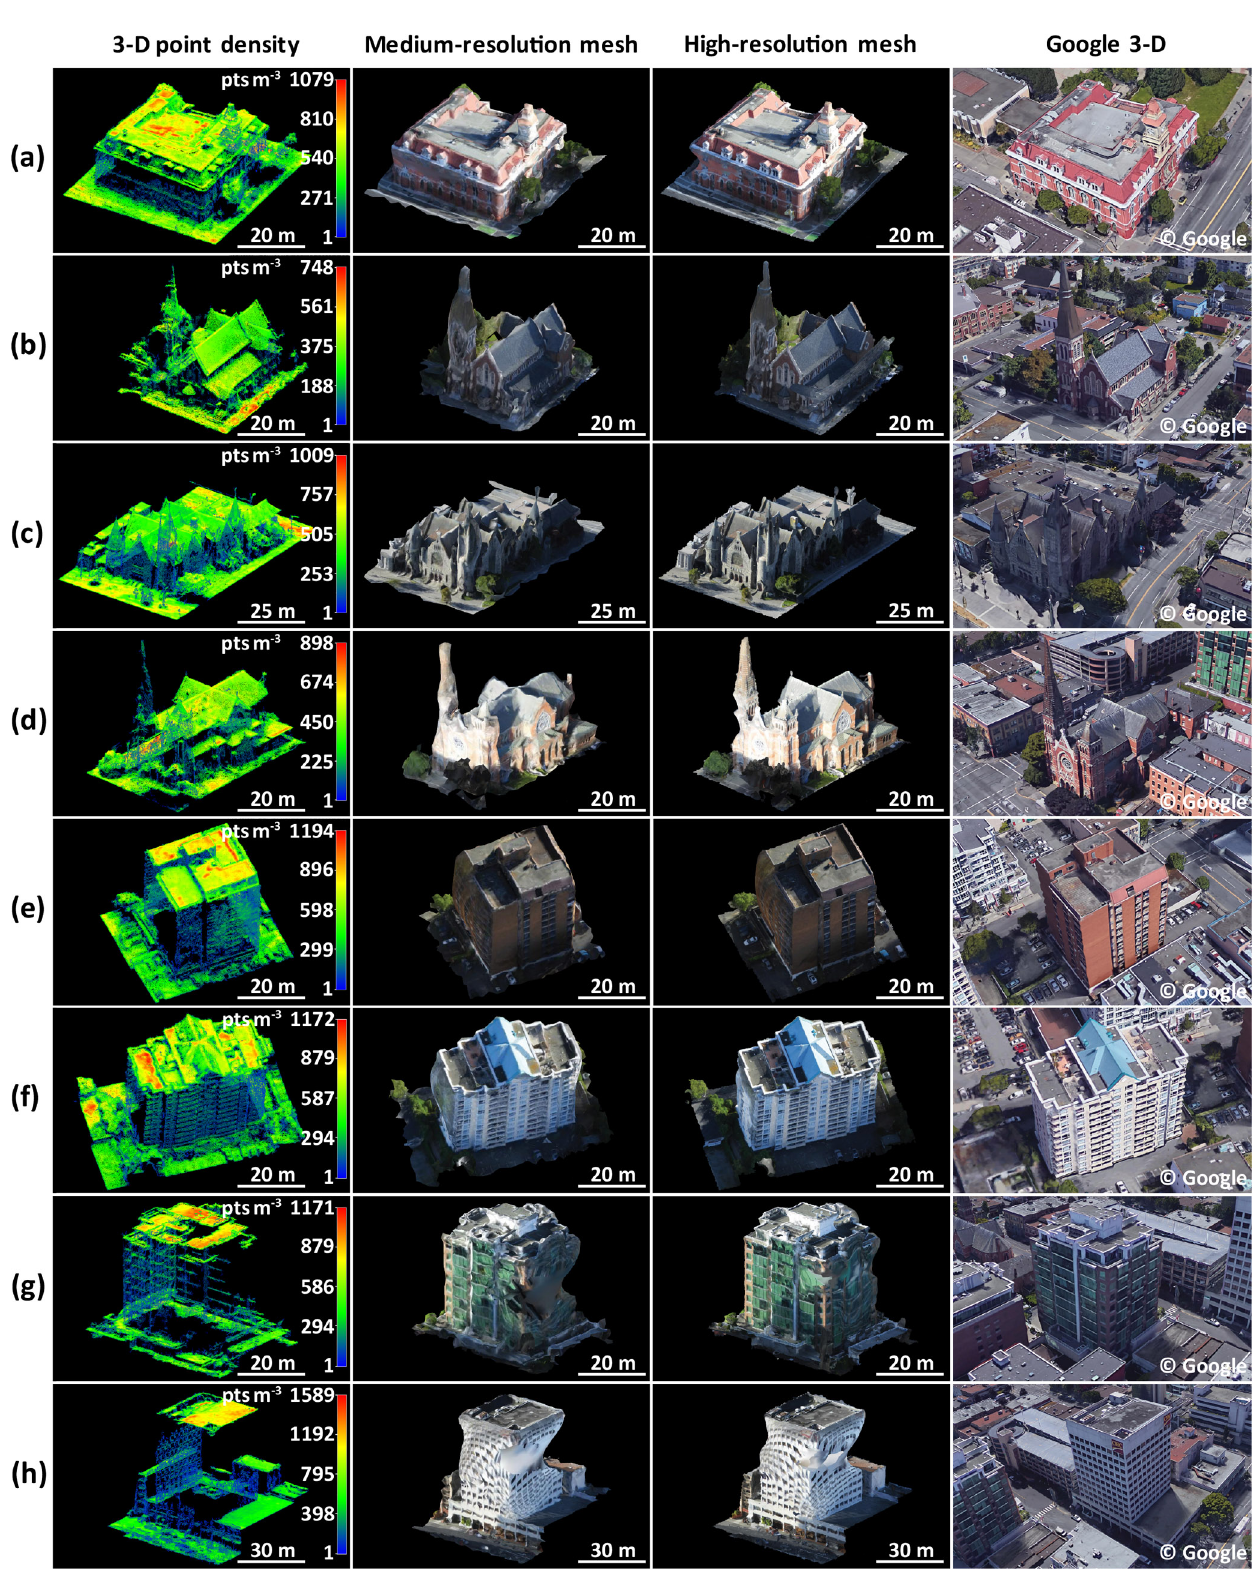
Figure 2. Sample buildings segmented from the dense point cloud (colored by 3-D point density), medium-resolution mesh, and high- resolution mesh. Both meshes were generated using identical input imagery and processing settings, except for the mesh resolution setting. Google 3-D is shown as a reference for building appearance (© Google Earth; Google,